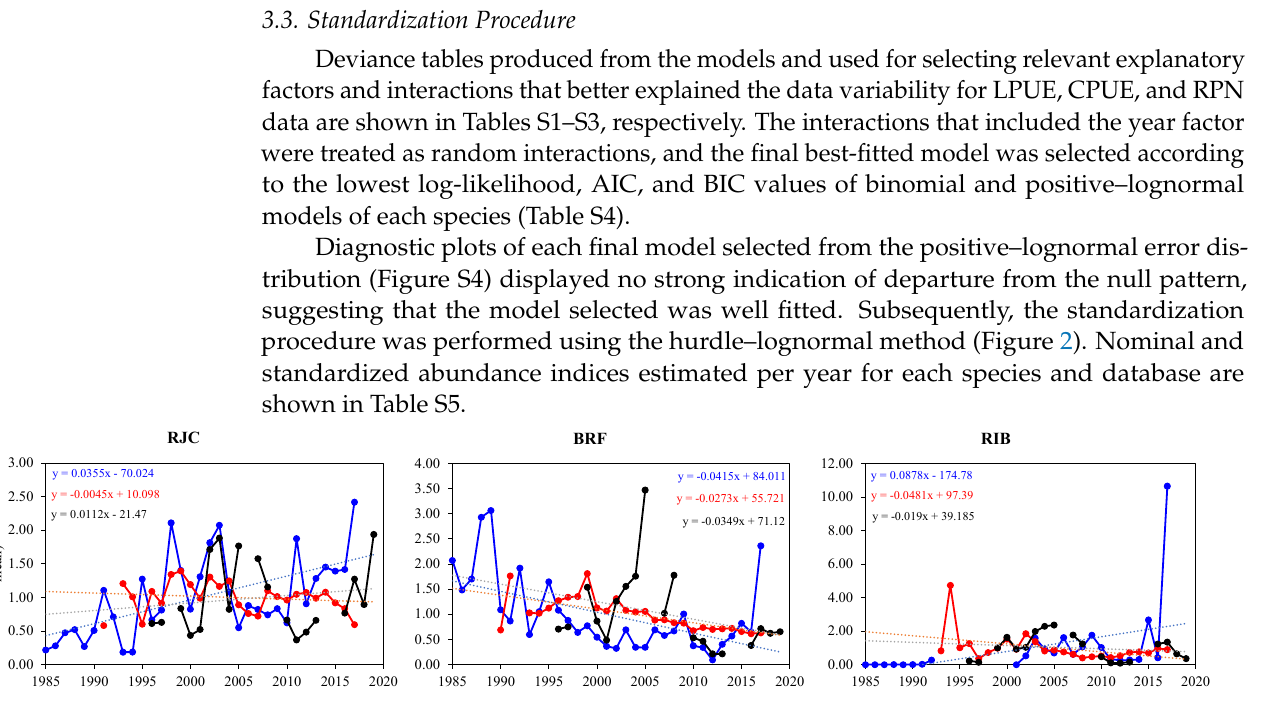
Figure 2. Standardized LPUE (in blue), CPUE (in red), and RPN (in black color) for thornback ray Raja clavata (RJC), blackbelly rosefish Helicolenus dactylopterus (BRF), and common mora Mora moro (RIB) in the Azorean region. The dashed lines represent the linear regressions (the equations are indicated in the graph).